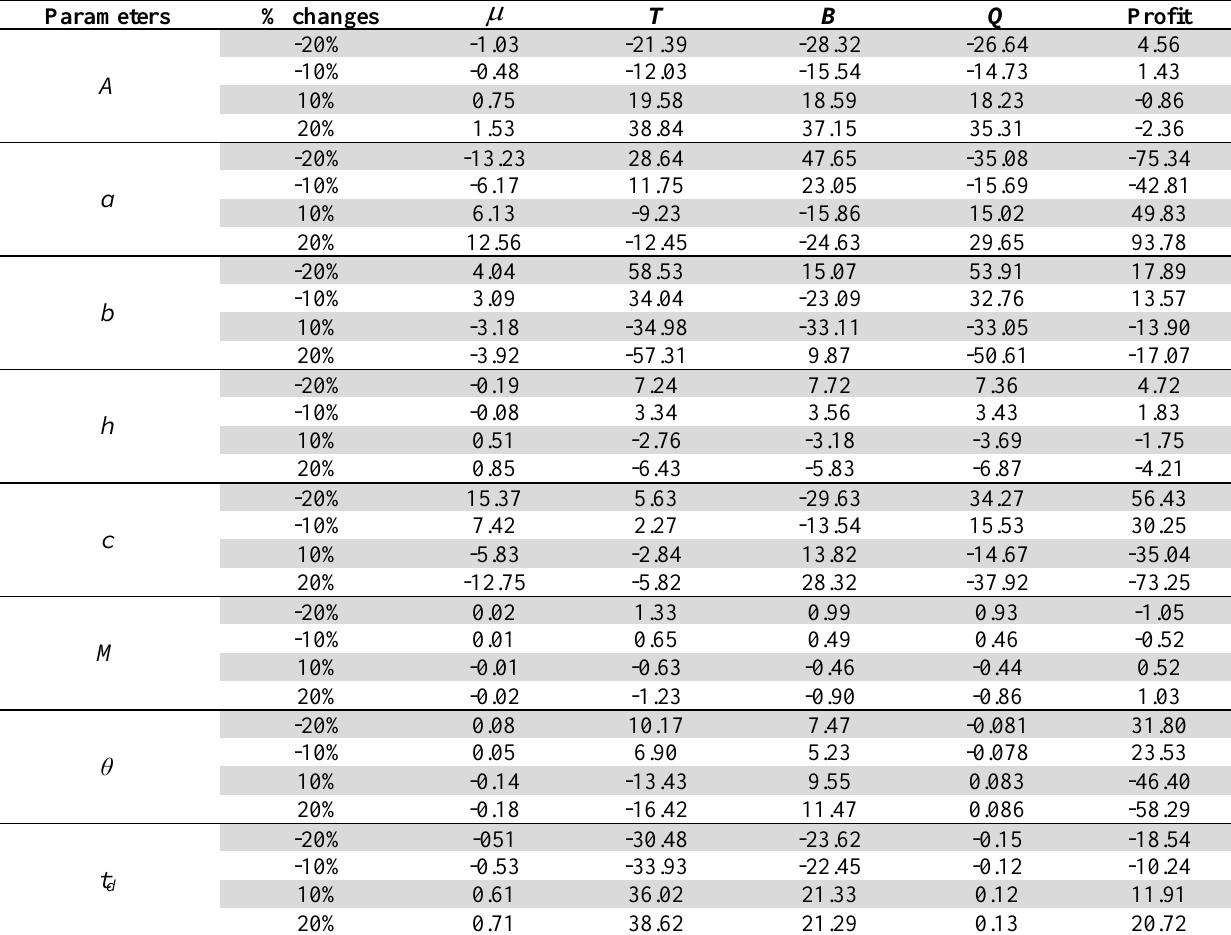
Table 3 Effect of changes in the system parameters